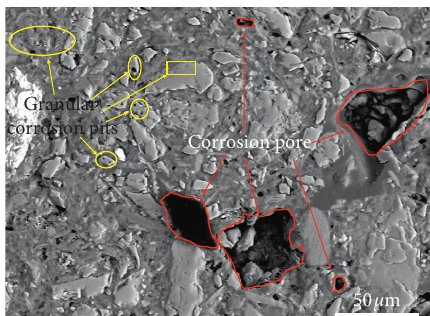
Figure 9: Original scanning electron microscope image of acid-etched loess (magnified 500x), HCl concentration 3 mol/L, and immersion time of 12 days.